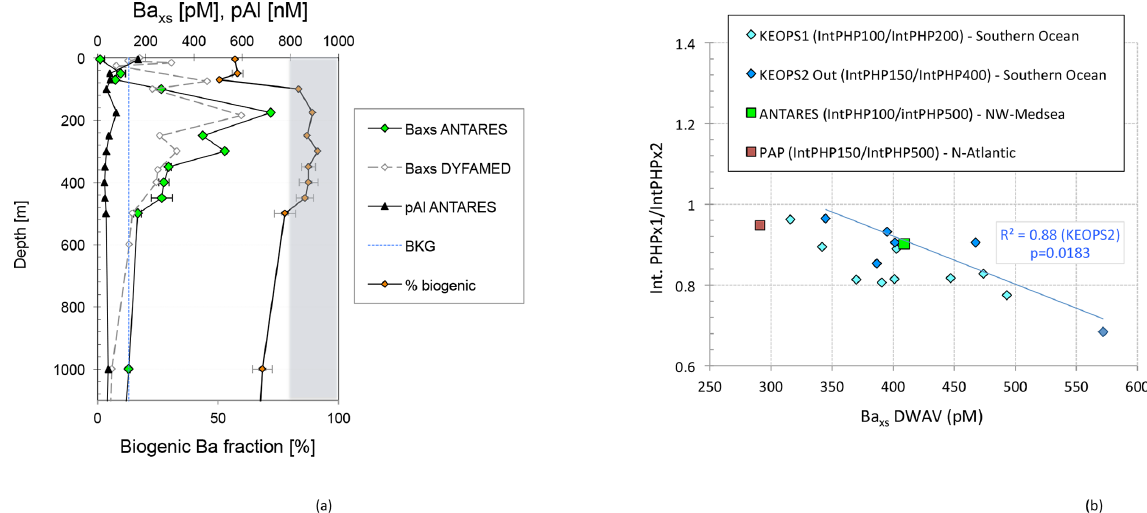
Figure 2. (a) Particulate biogenic Ba xs (pM) and particulate Al (nM) profiles next to the biogenic Ba fraction (%) in the upper 1000m at ANTARES. The grey area represents a biogenic Ba fraction larger than 80%. BKG: Ba xs background. Ba xs profile (pM) at DYFAMED: data from Sternberg et al. (2008). (b) ANTARES ratio plot (green square) of integrated PHP in the upper 100m over integrated PHP in the upper 500m versus depth-weighted average (DWA) mesopelagic Ba xs (pM) over the 100–500m depth interval. Regression of the same ratio is reported for KEOPS1 (light blue symbols; out plateau stations) and KEOPS2 (dark blue symbols; Southern Ocean, Jacquet et al., 2015) and DY032 (red square; PAP station, NE Atlantic; pers. data) cruises. The blue line represents the trend obtained during KEOPS2 (Jacquet et al.,